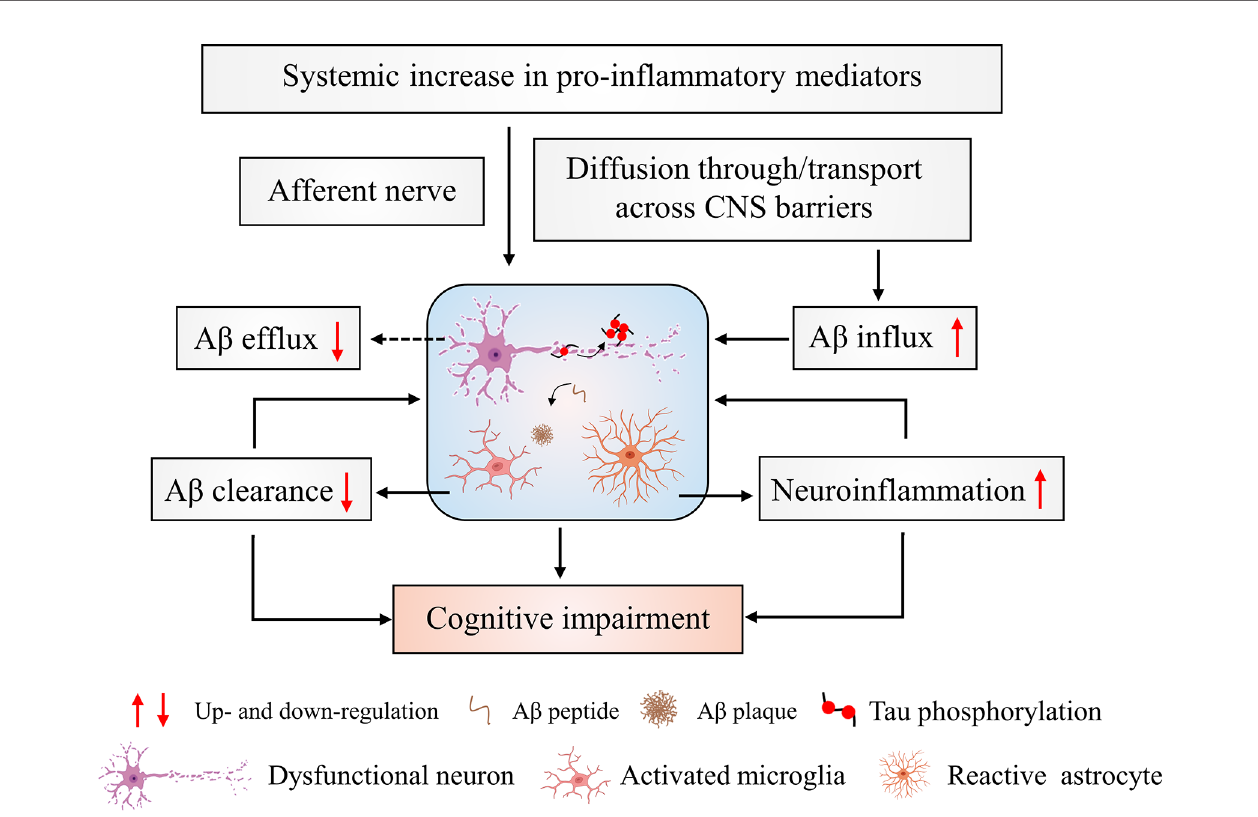
FIGURE 2 | Cerebral changes in response to systemic in fl ammation. Systemic in fl ammation leads to increased levels of pro-in fl ammatory mediators. These signals can project to the brain via nerve afferents and the brain barriers. This can directly and/or indirectly induce neuronal cytotoxicity and affect A b transport resulting in increased A b aggregation. The aggregated A b induces an initial activation of microglial cells that leads to activated microglial cells with an impaired A b clearing ability. Additionally, the activated microglial cells produce a large amount of pro-in fl ammatory cytokines that further exacerbate neuroin fl ammation. This worsening of neuroin fl ammation promotes the development of brain pathology and ultimately leads to cognitive